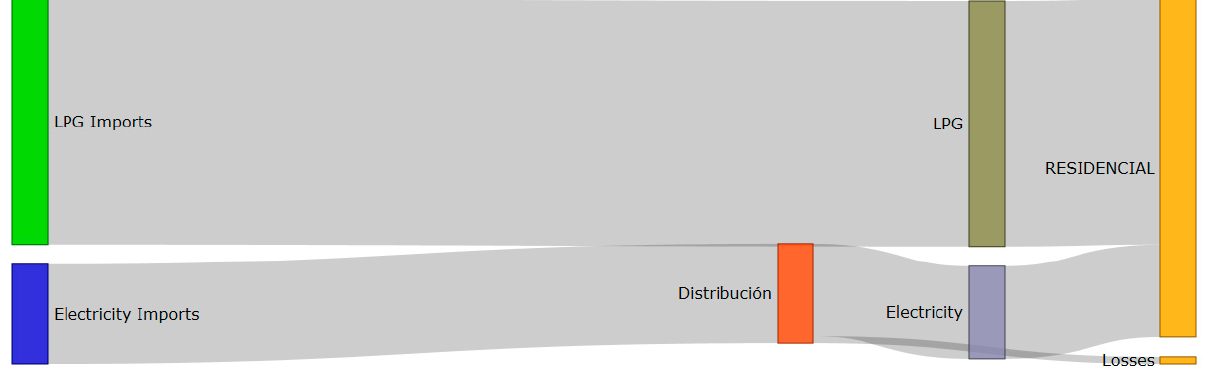
Figure 4. Scenario 0. Energy consumption in 2030, residential sector. Figure 6. Scenario 1. Energy consumption in 2030, residential sector.